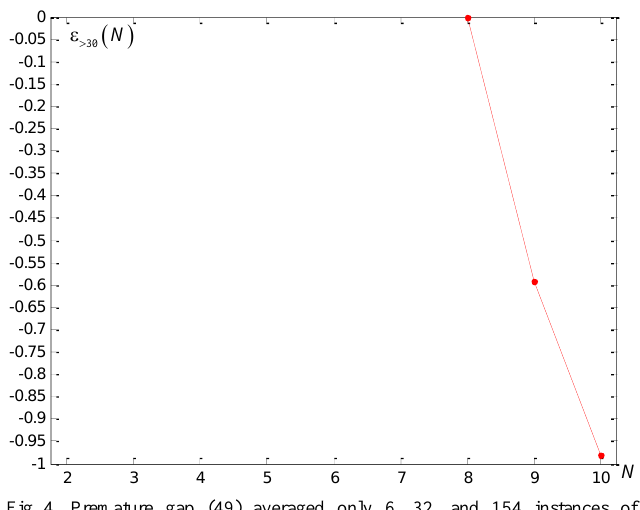
Fig. 4. Premature gap (49) averaged only 6, 32, and 154 instances of scheduling 8, 9, and 10 jobs, respectively. The drop is seemingly almost linear.